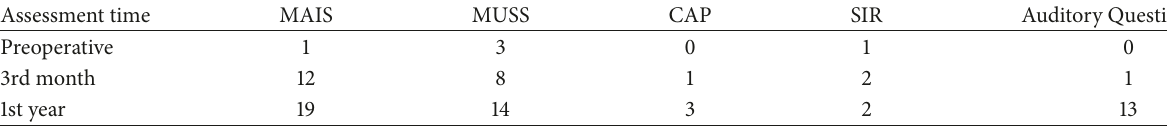
Table 1: Auditory Questionnaire results for Case 1 .